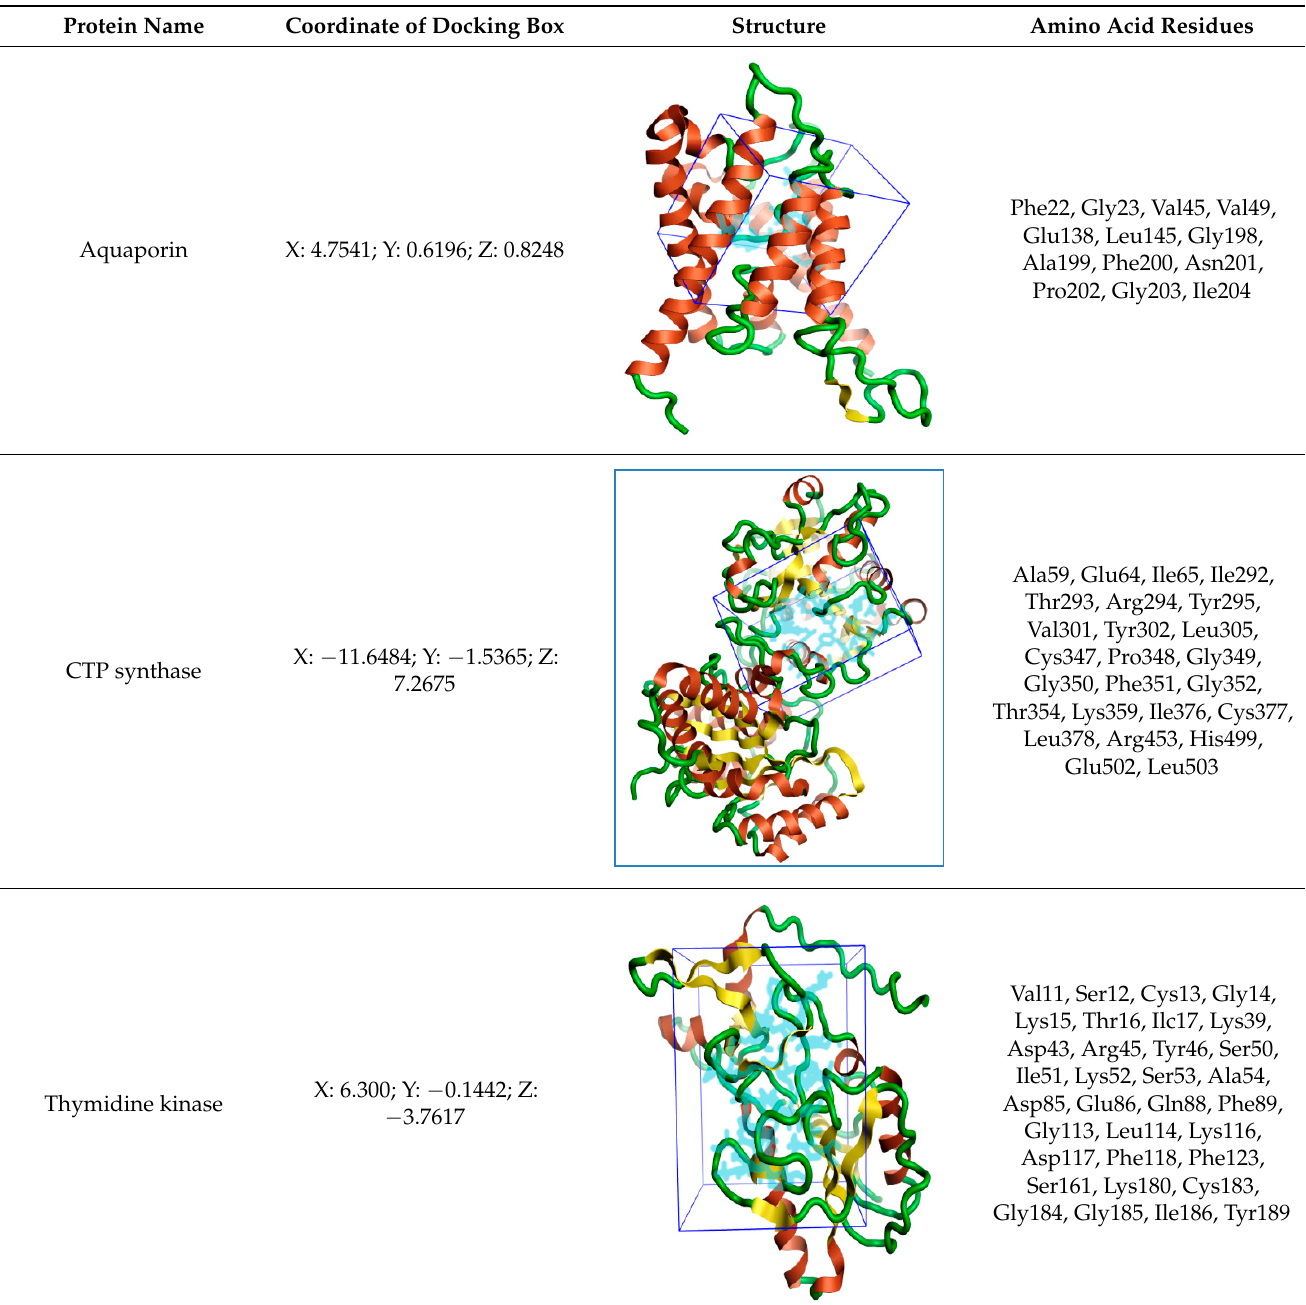
Table 1. Identification of binding pockets in the five druggable protein targets of EHP and generation of grid box for molecular docking studies.